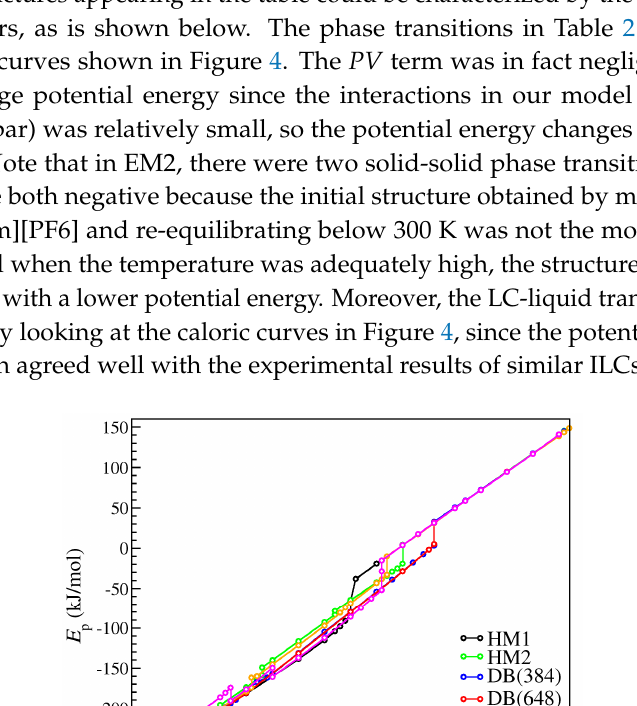
Figure 3. Snapshots of [C 14 Mim][NO 3 ] beginning with the HM1 structure at various temperatures. ( a ) HM1 crystal at 200 K; ( b ) Metastable state during the solid ‐ liquid crystal (LC) transition at 455 K; ( c ) SmA LC at 550 K; ( d ) Nanoscale segregation liquid (NSL) at 650 K. The transition temperatures and corresponding potential energy changes are listed in Table 2.